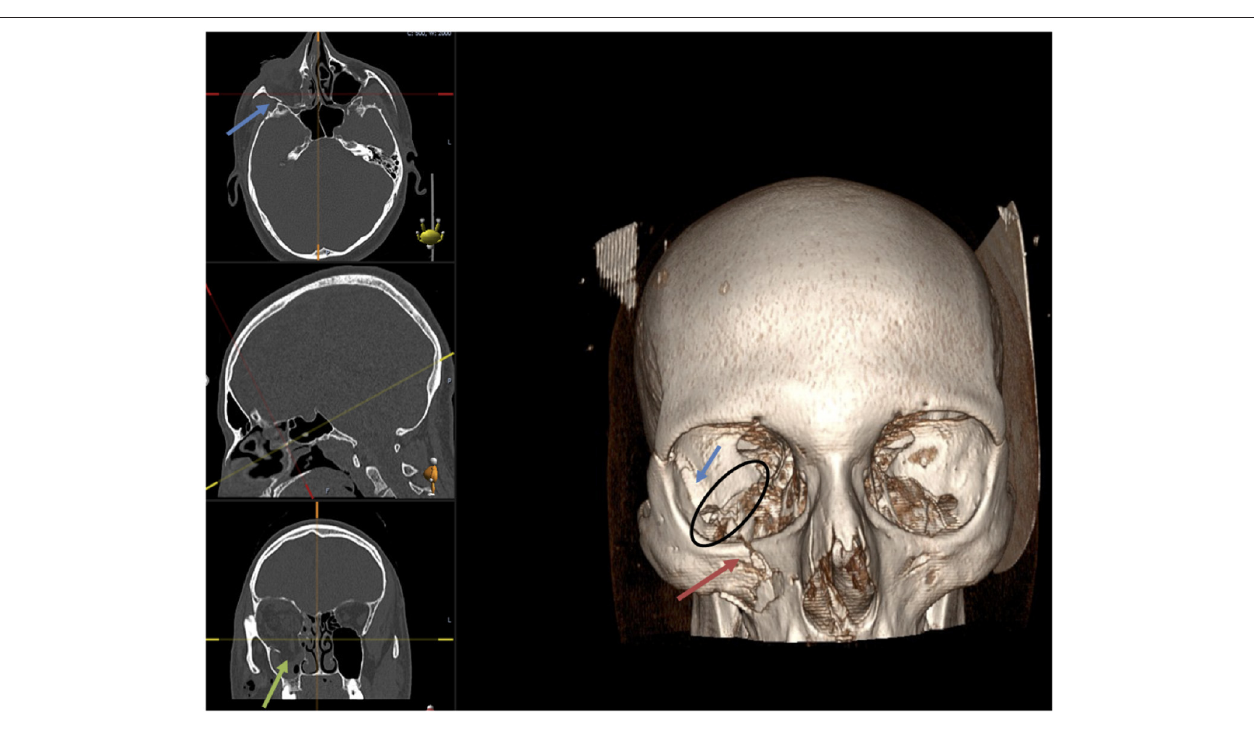
FIGURE 2 | Facial bones CT demonstrating right orbital floor fracture (green arrow), lateral wall fracture (blue arrow) with the involvement of the infra-orbital rim (red arrow). The black circle shows the inferior orbital fissure (IOF) involved in the fracture on the right side compared to the left orbit.